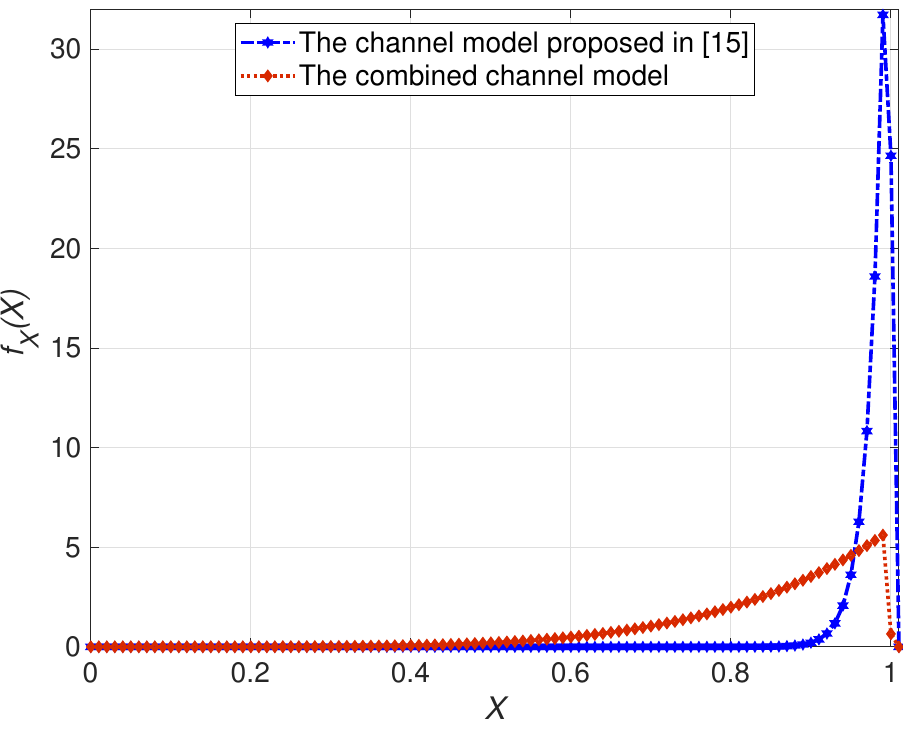
Figure 4. The combined channel model distribution f X ( X ) for the case of strong atmospheric turbulence channel, the transmitter beam waist radius ω 0 = 0.02